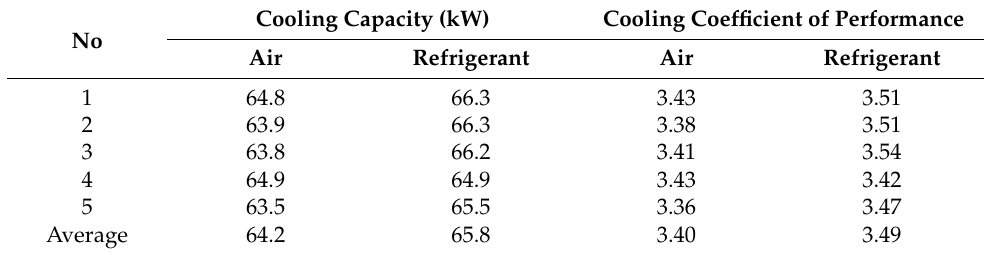
Table 18. Air side and refrigerant side cooling performance result (five times).